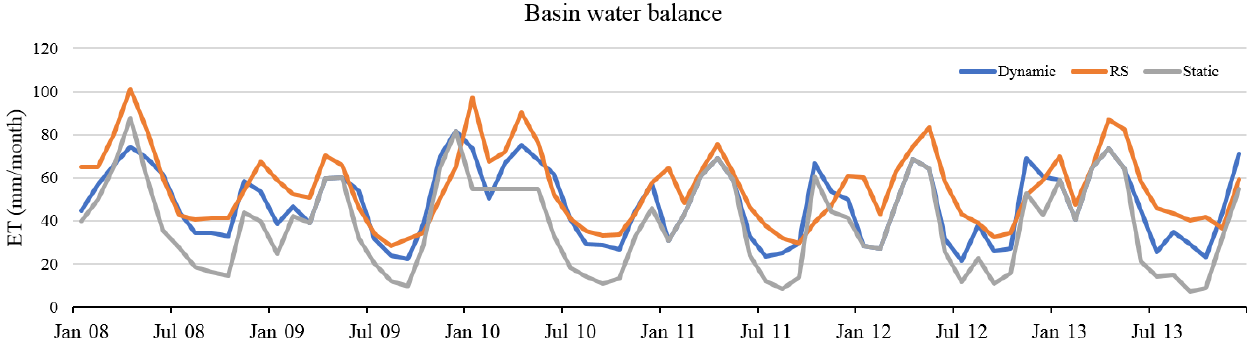
Figure 4. Average monthly ET for the basin scale summarised from remote sensing and the dynamic land use scenario and static land use scenario.